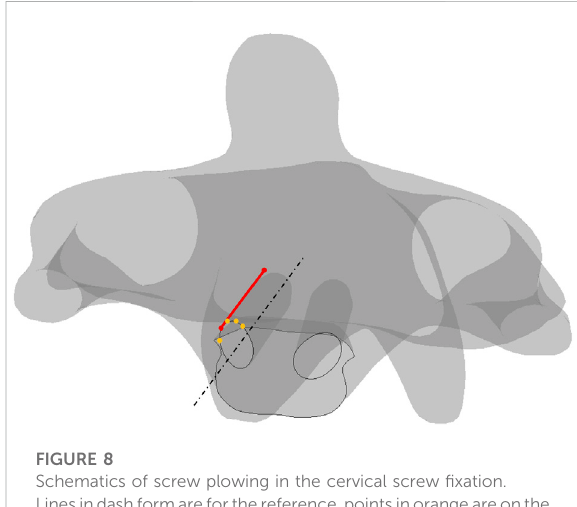
FIGURE 8 Schematics of screw plowing in the cervical screw fi xation. Linesindashformareforthereference,pointsinorangeareonthe trajectory, the line in red represents the shortest length from the anterior section to the posterior